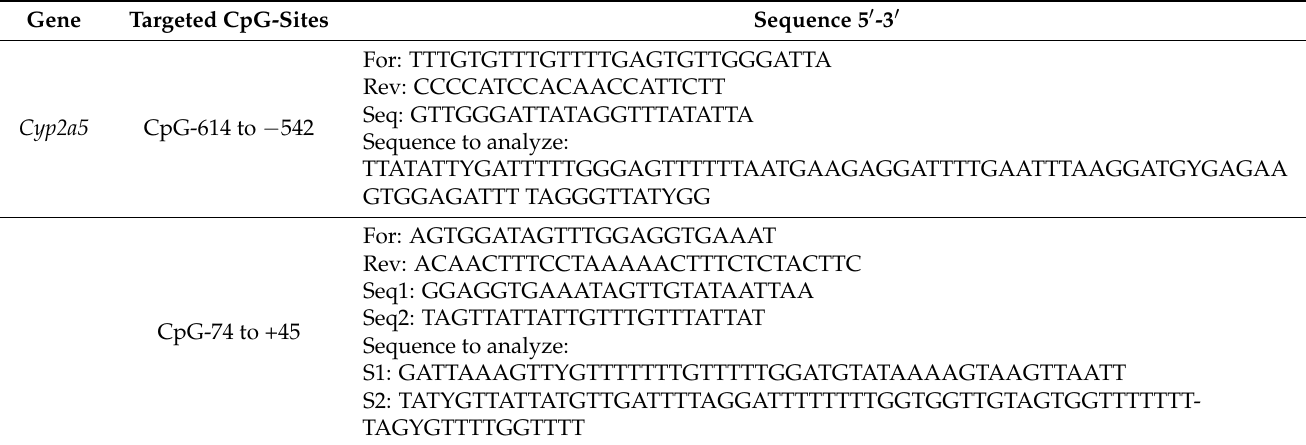
Table 2. Sequences of primers used in bisulfite-based methylation analysis. Gene Targeted